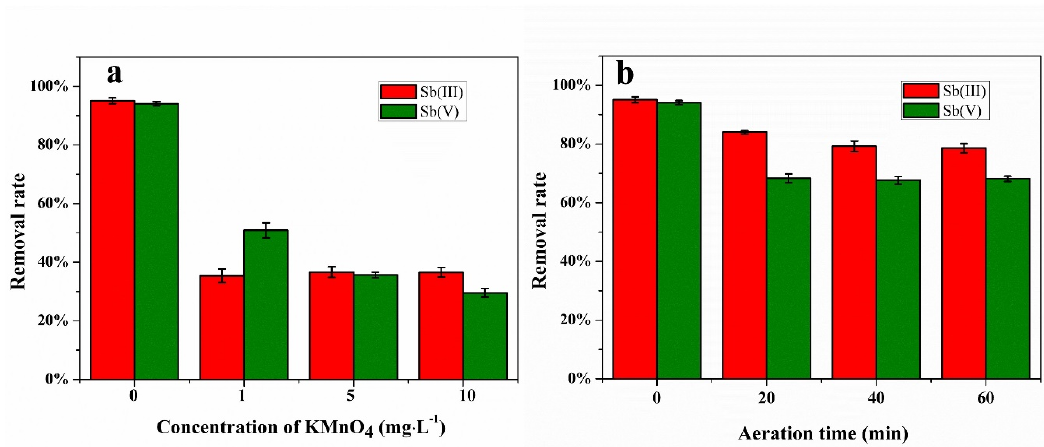
Figure 5. ( a ) E ff ects of the concentration of KMnO 4 in oxidation on the removal of Sb, and ( b ) e ff ects of aeration time on the removal of Sb (the initial concentrations of Sb(III) and Sb(V): 200 µ g · L − 1 ; dosage of PFS as Fe:10 mg · L − 1 ).